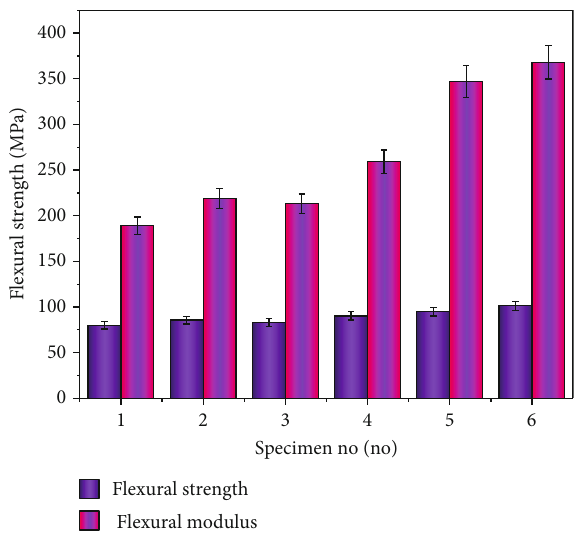
Figure 3: Flexural properties of coir/pineapple/Al based nanocomposites.